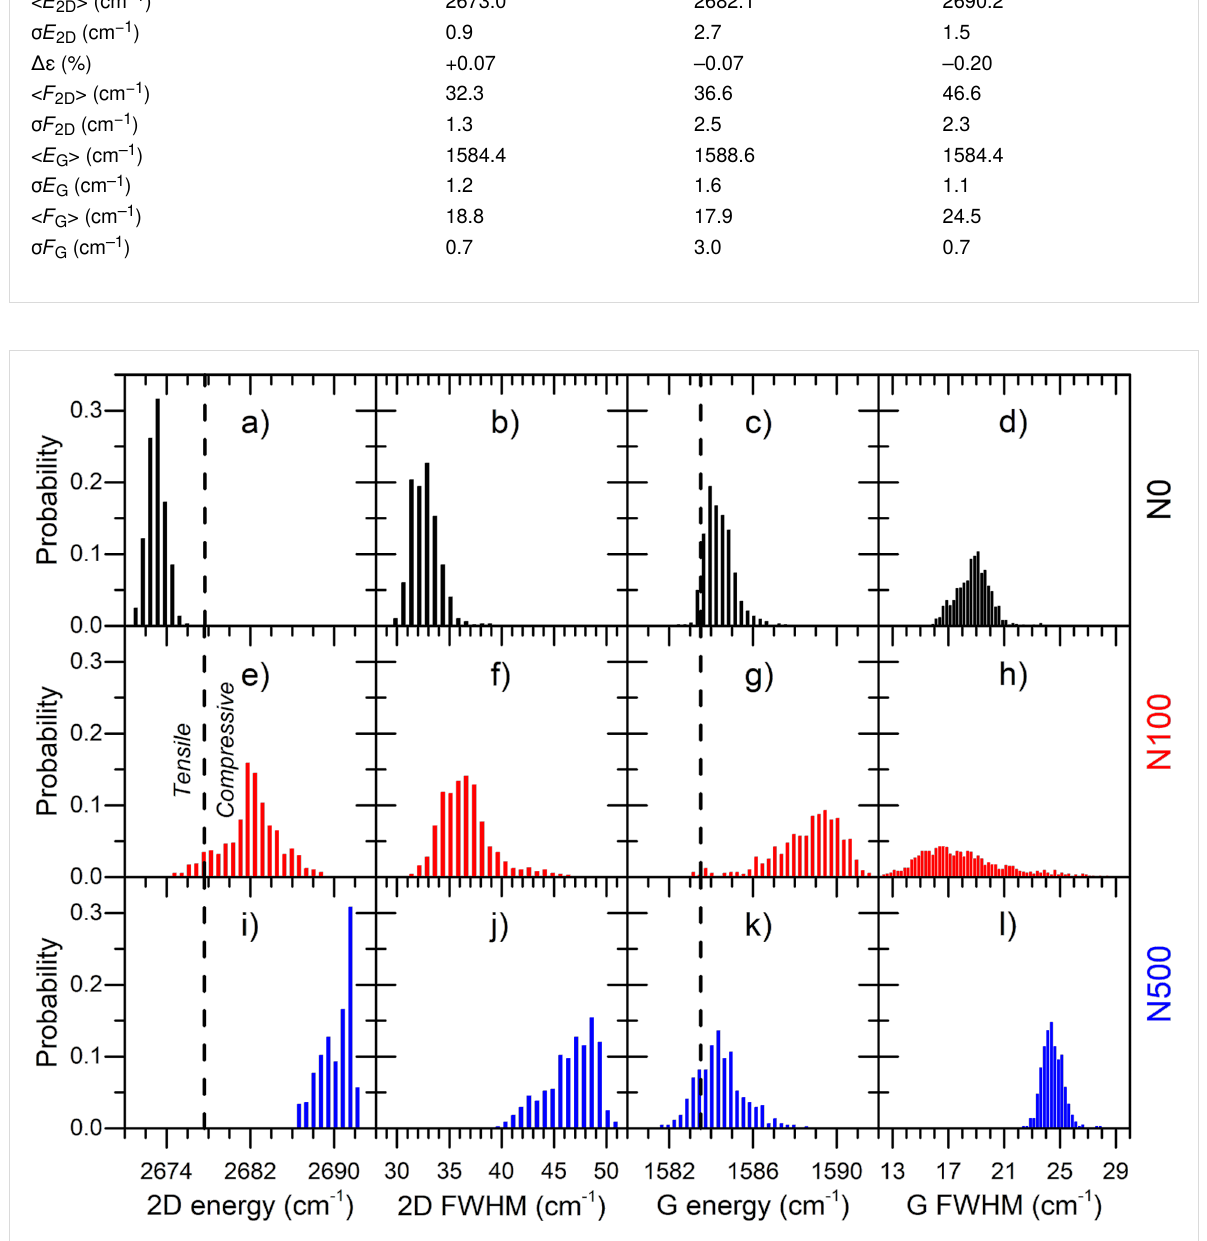
Figure 3: Histograms of 2D band energy (a,e,i), 2D FWHM (b,f,j), G band energy (c,g,k) and G FWHM (d,h,l) for N0, N100, and N500 samples, re- spectively. Dashed vertical lines correspond to 2D and G band energy values for unstrained and undoped graphene obtained from the literature